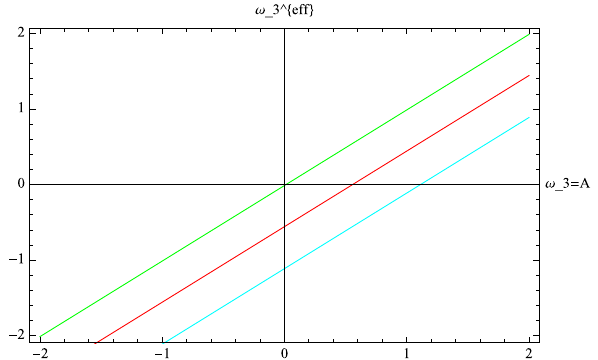
Fig. 4 Variation of ω ef f with ω 3 for β = 10 (Blue), β = 5 (Green), 3 β = 0 . 1 (Red) for D = 10, β = 0 . 1 (Cyan) and β = 5 (Yellow) for D =